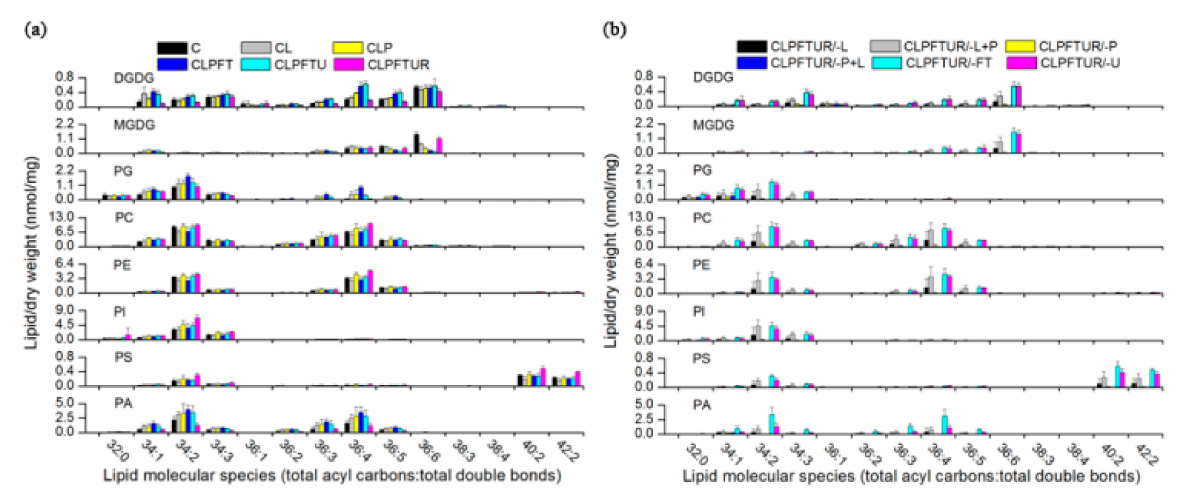
Figure 6. Changes in levels (nmol/mg) of the molecular species of galactolipids and phospholipids during various Magnolia officinalis EC cryopreservation protocols. ( a ) Standard-protocol cryopreservation steps. ( b ) Altered-protocol cryopreservation. See Figure 1 legend for treatment notation. Values are mean ± SD ( n =